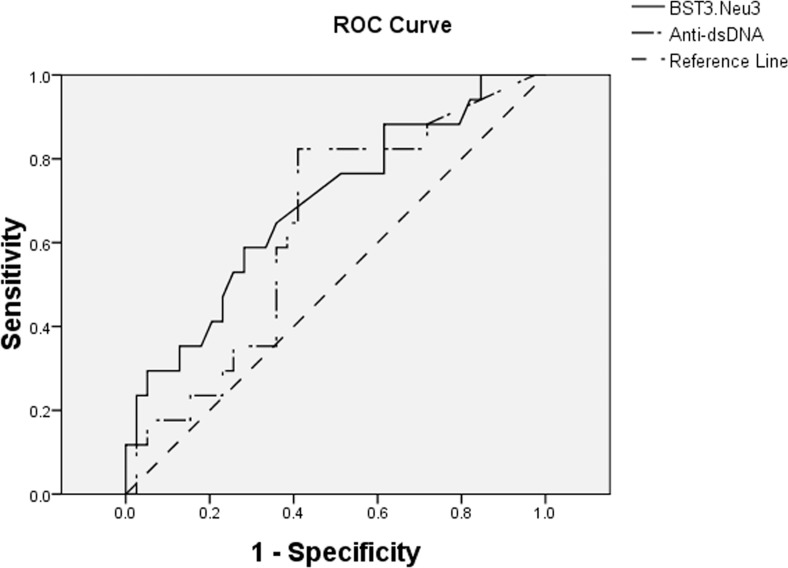
ROC curves of cell ST3Gal-1/Neu3 raios and serum anti-dsDNA levels against SLEDAI scores.The ROC curve of the B-cell ST3Gal-1/Neu3 ratio (Bst3neu3) against SLEDAI (n = 57) yielded an AUC of 0.689, which was comparable to the AUC of 0.635 for the anti-dsDNA level (Anti-dsDNA) against SLEDAI (n = 57).